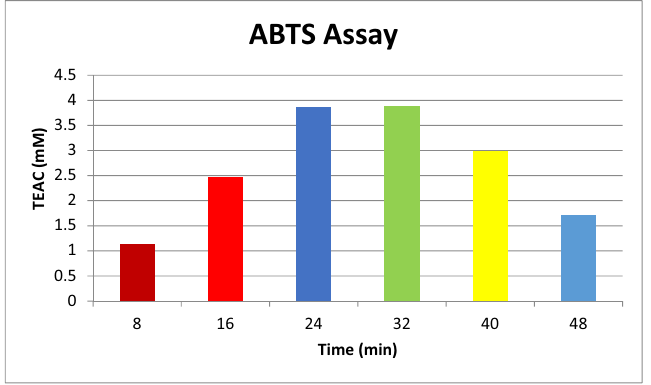
Figure 10. ABTS assay of biosynthesized silver nanoparticles at different time intervals. TEAC stands for Trolox equivalent antioxidant capacity and it represents the antioxidant potential of Trolox solution with equivalent concentration of sample under investigation.